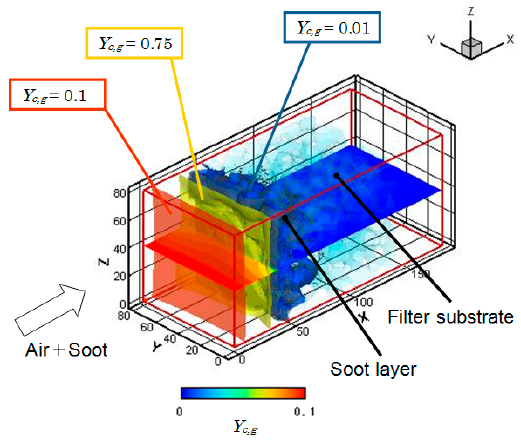
Figure 7. Three-dimensional distribution of soot mass fraction in gas phase in Filter 1 at t = 15 s.